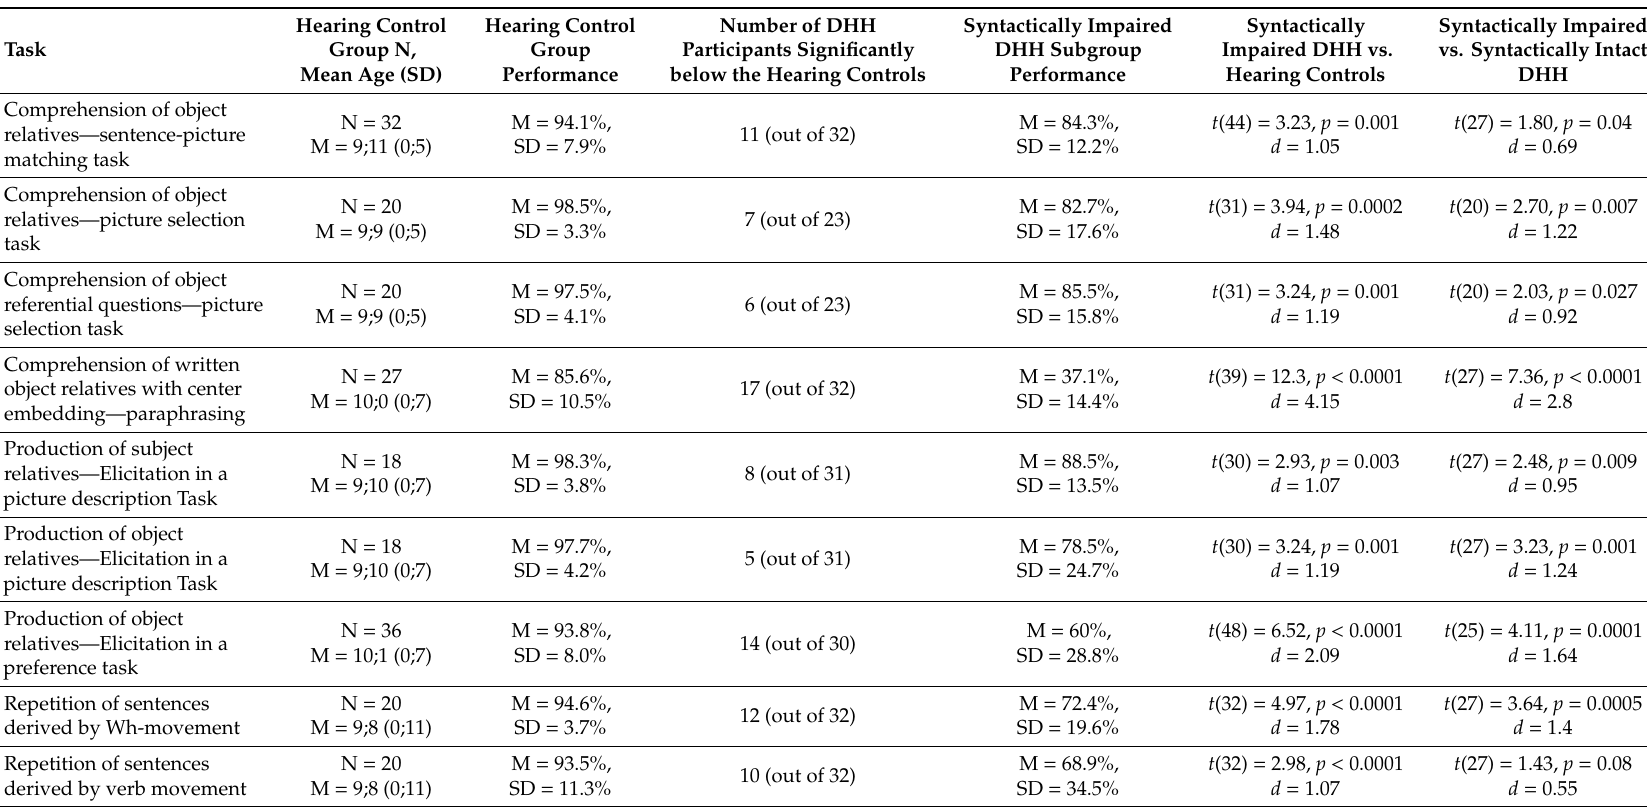
Table A1. Performance of the syntactically impaired DHH participants and the hearing control group (typically developing hearing Hebrew-speaking children in fourth and fifth grade) in the syntactic